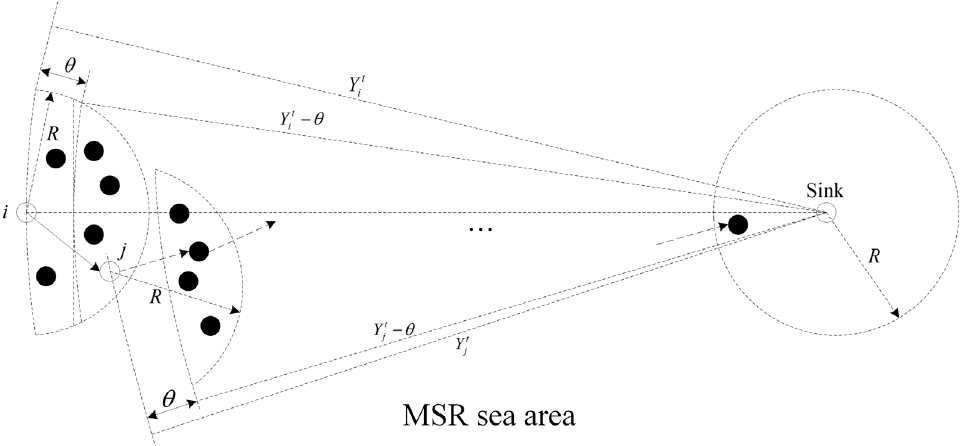
Figure 2. Forwarding path of the proposed opportunistic routing protocol.